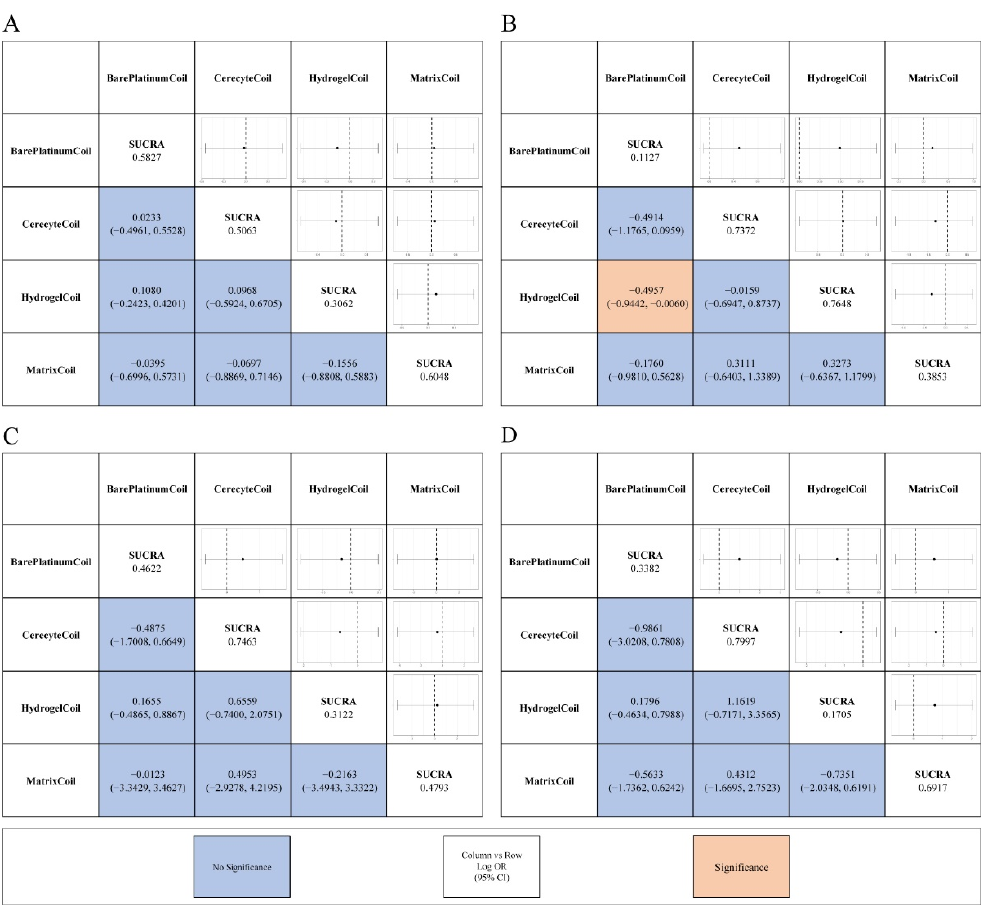
Figure 3. League tables for the outcomes of efficacy and safety generated using fixed or random effect models. ( A ) Percentage of postoperative patients with modified Raymond scale grade I; ( B ) Percentage of patients with modified Raymond scale grade I at follow-up; ( C ) Rates of intraopera- tive aneurysm rupture or re-rupture; ( D ) Mortality rate.